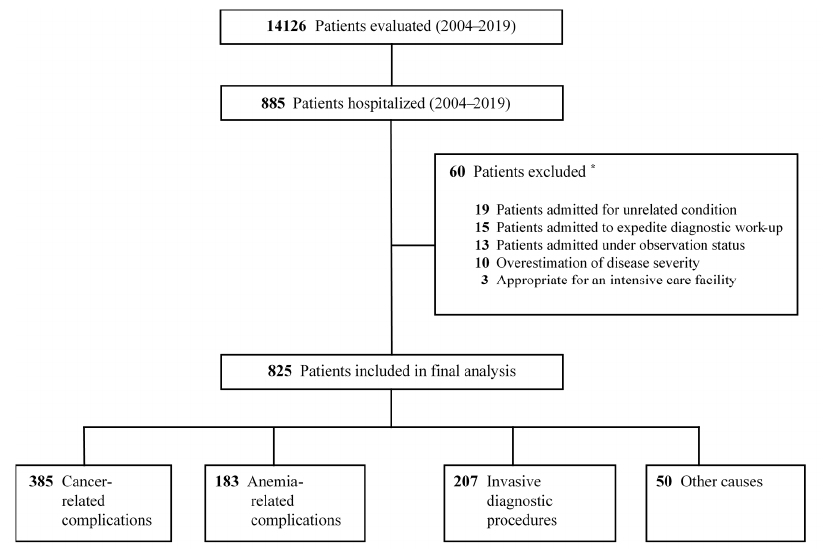
Figure 1. Flowsheet for the patient selection process. * According to independent assessment of appropriateness of admission decisions.